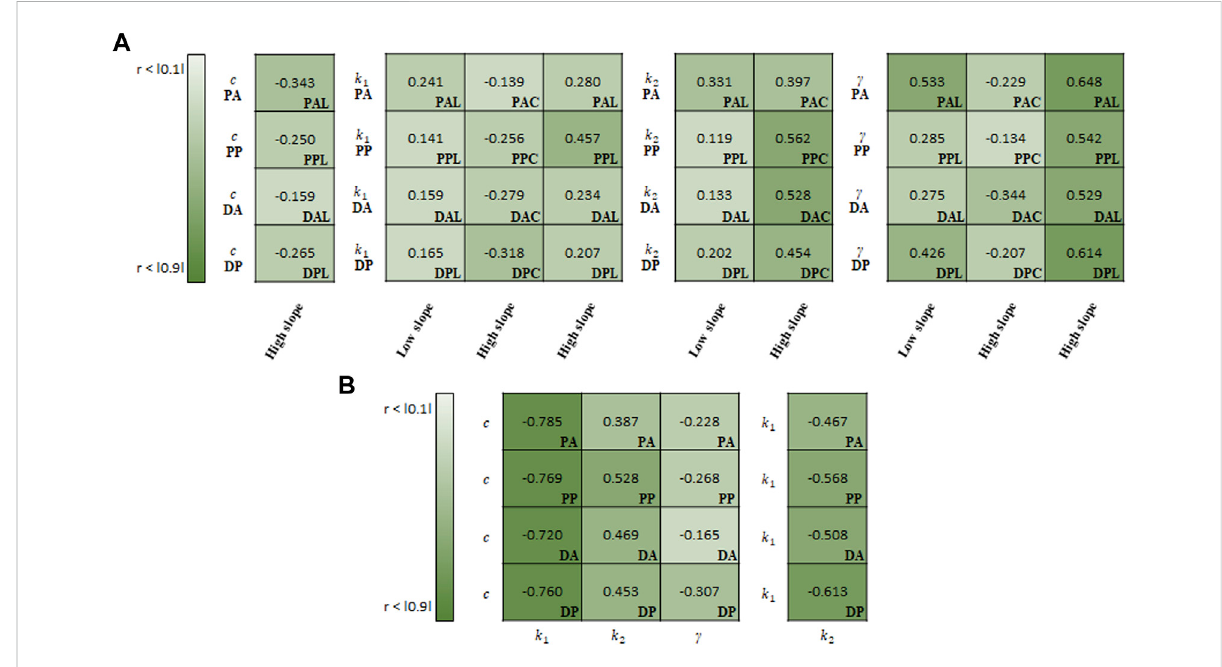
FIGURE 10 Spearman rank correlation coef fi cients (A) between material parameters of Holzapfel model and experimental results and (B) among the material parameters.